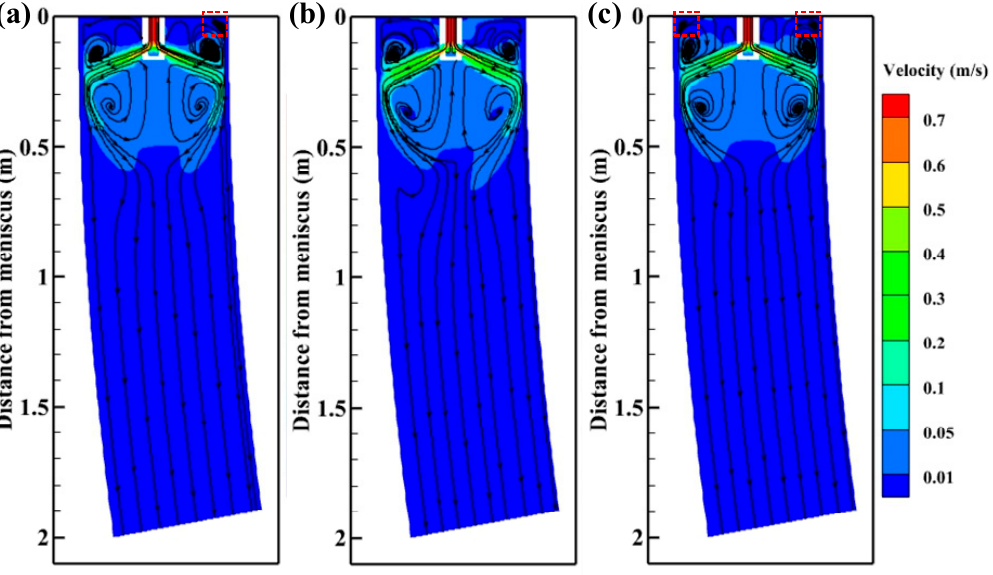
Figure 6. Velocity contours and streamlines on the plane Y = 0 m without M-EMS ( a ) –15° SFN, ( b ) 0° SEN, and ( c ) +15° SFN.